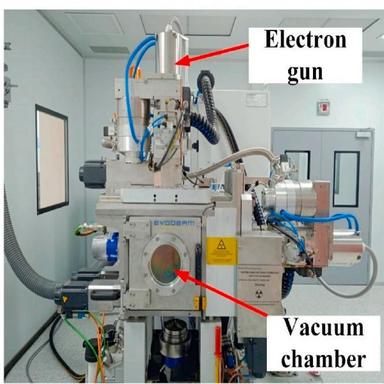
Evobeam Cube200 electron beam welding setup.